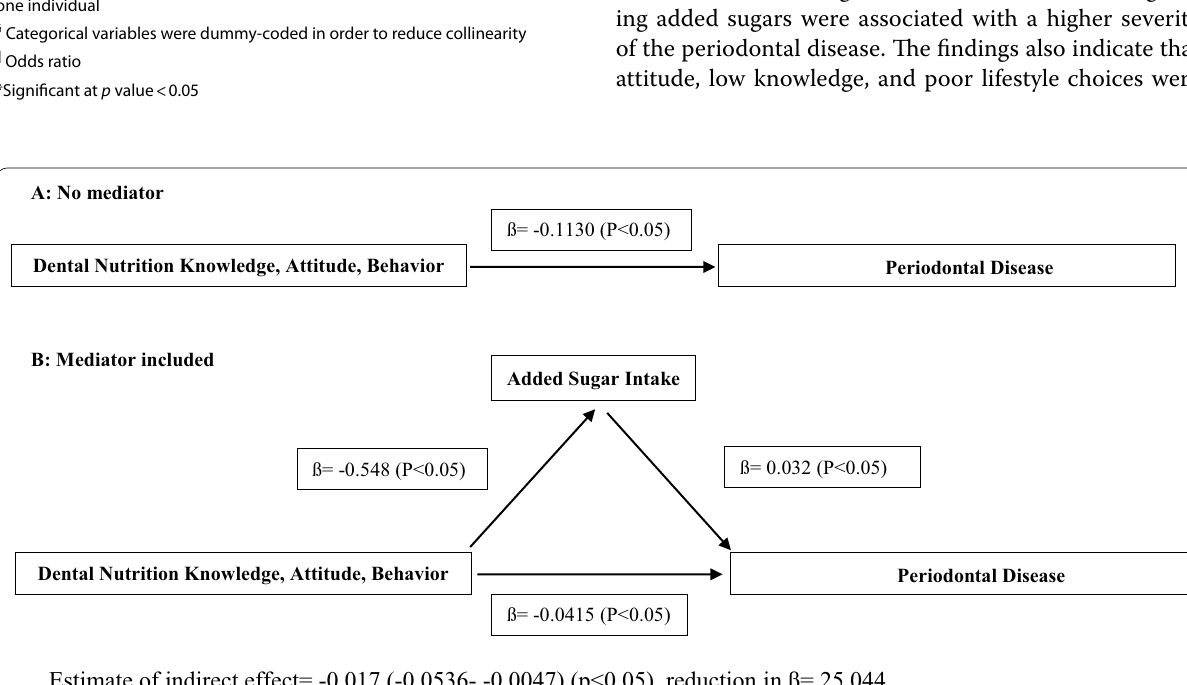
Fig. 1 A Direct effect of the independent variable of dental nutrition knowledge, attitudes, and beliefs on the dependent variable of periodontal disease. B The mediation model indicates that added sugar intake mediates the influence of dental nutrition knowledge, attitudes, and beliefs on periodontal